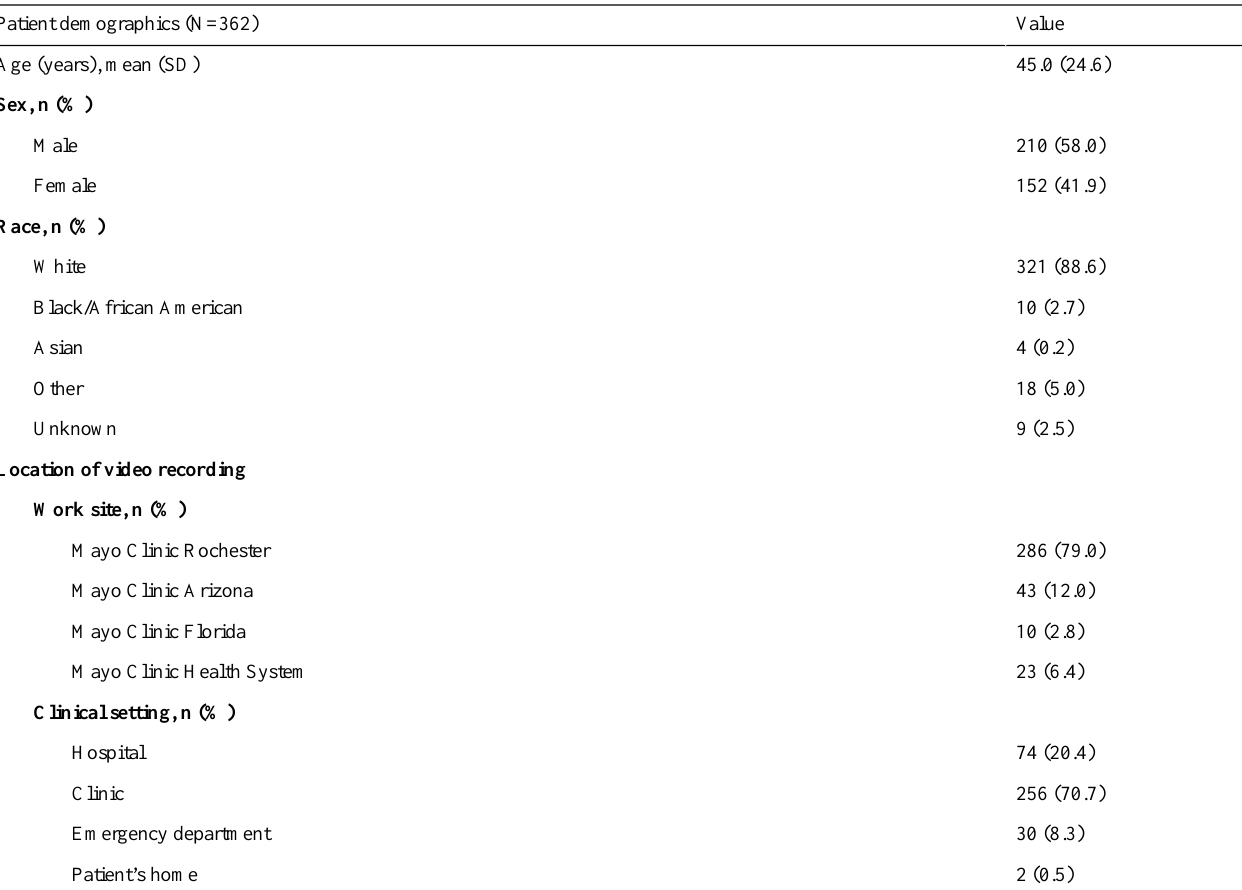
Table 1. Patient demographics and location of video recording, including work site and clinical